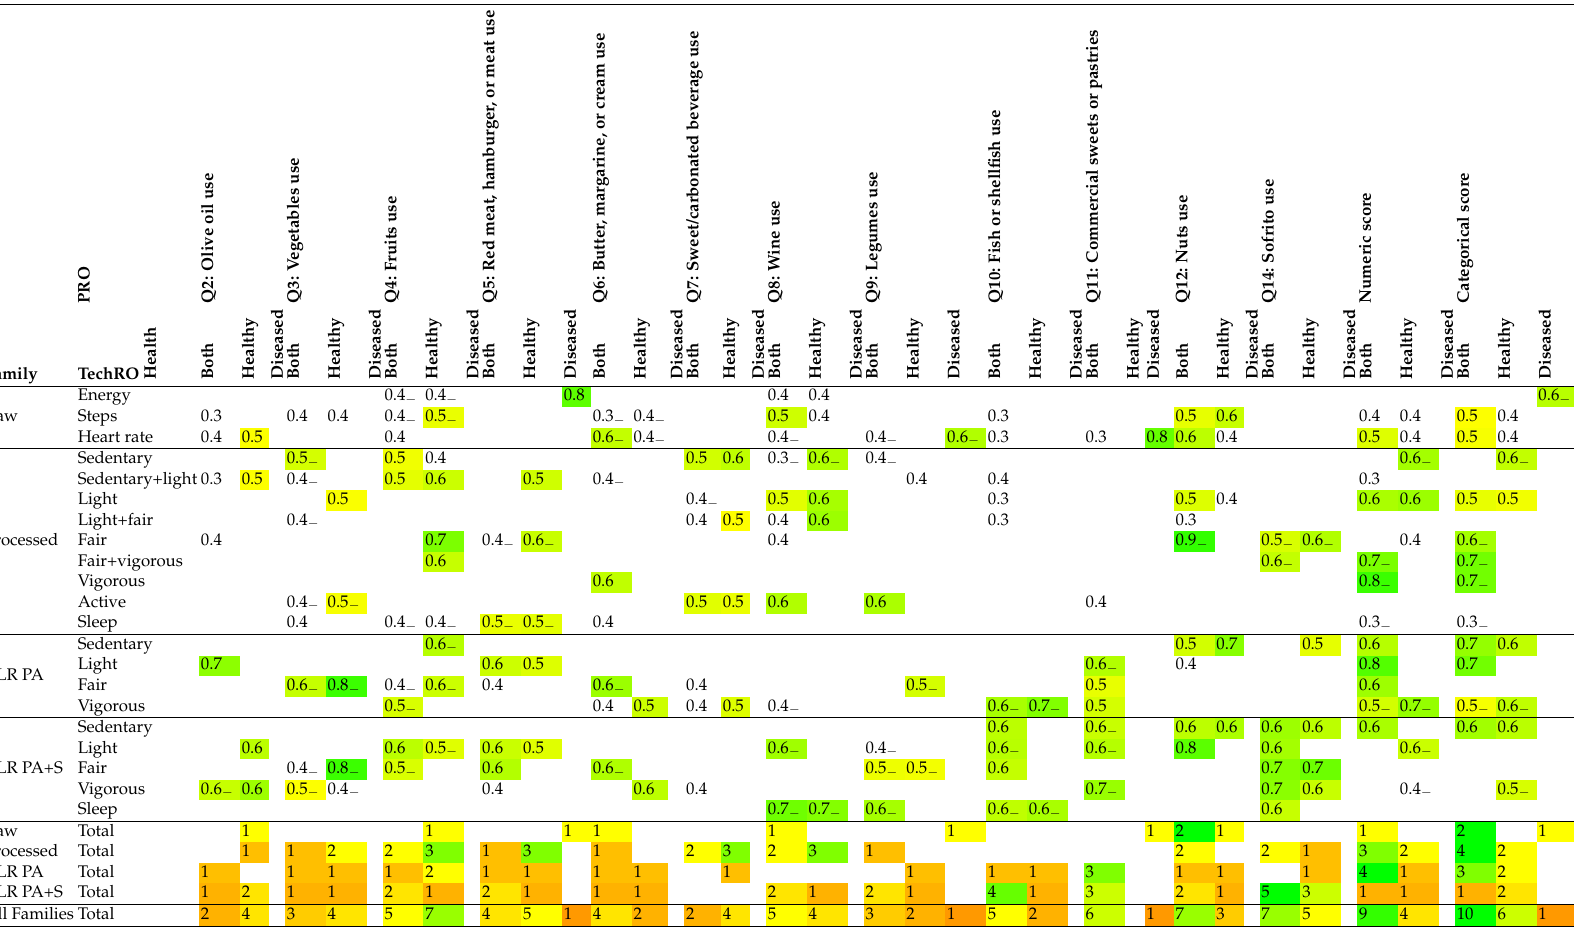
Color coding: from orange (weaker correlation/fewer total correlations) to yellow to green (stronger correlation/more total correlations). Only significant correlations are shown. Only coefficients of 0.5 or above are